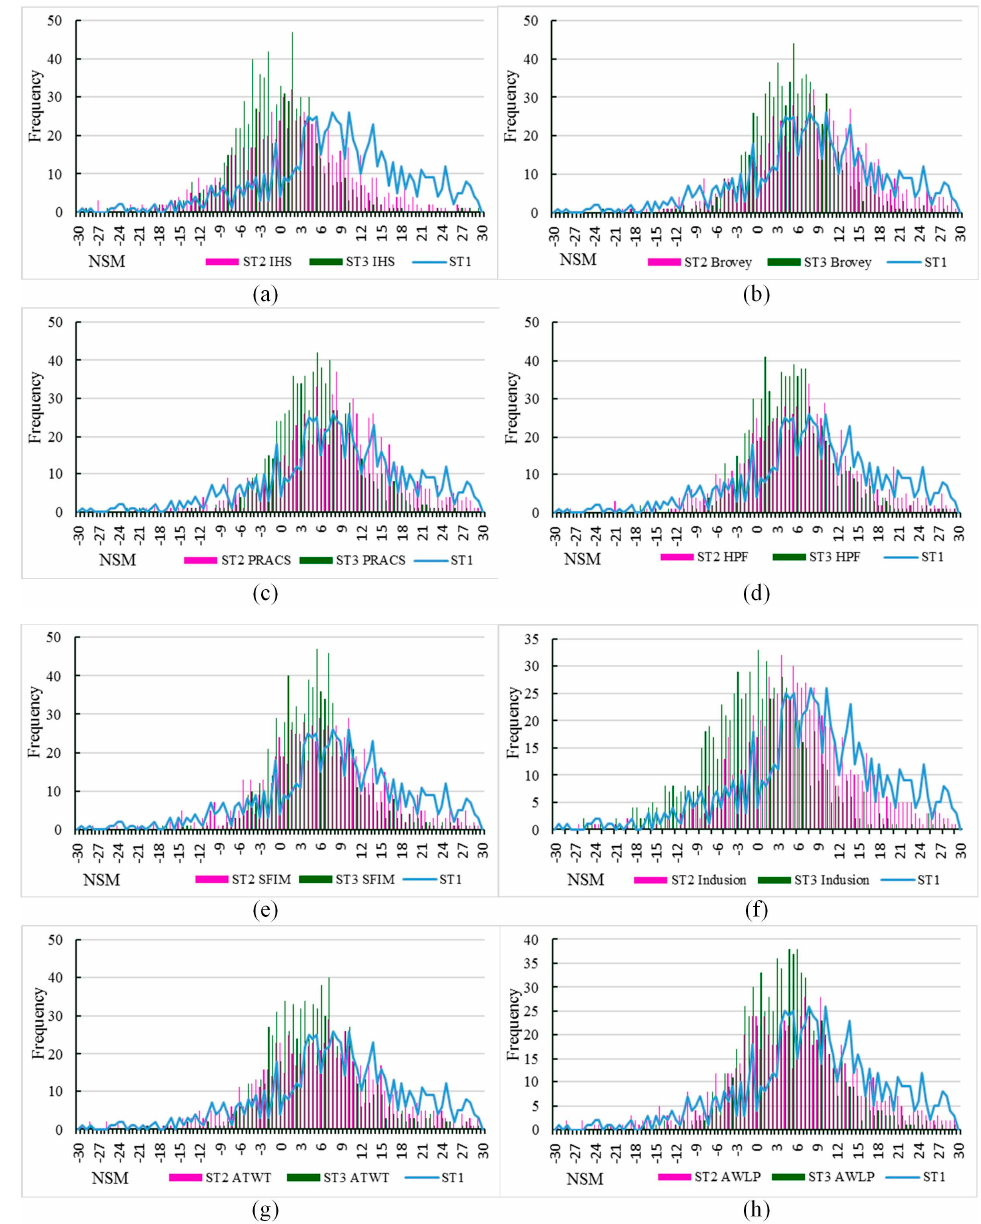
Figure 11. Histogram of NSM values of the extracted coastlines in strategy 1 (blue line), strategy 2 (red line) and strategy 3 (green line) with different methods: ( a ) IHS algorithm; ( b ) Brovey algorithm; ( c ) PRACS algorithm; ( d ) HPF algorithm; ( e ) SFIM algorithm; ( f ) Indusion algorithm; ( g ) ATWT algorithm; ( h ) AWLP algorithm.